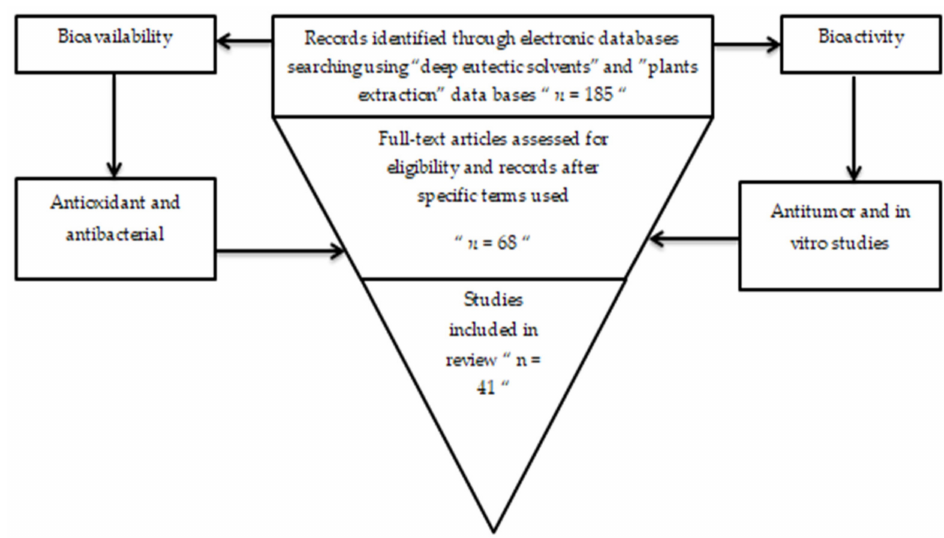
Figure 1. This is a figure for steps of the search